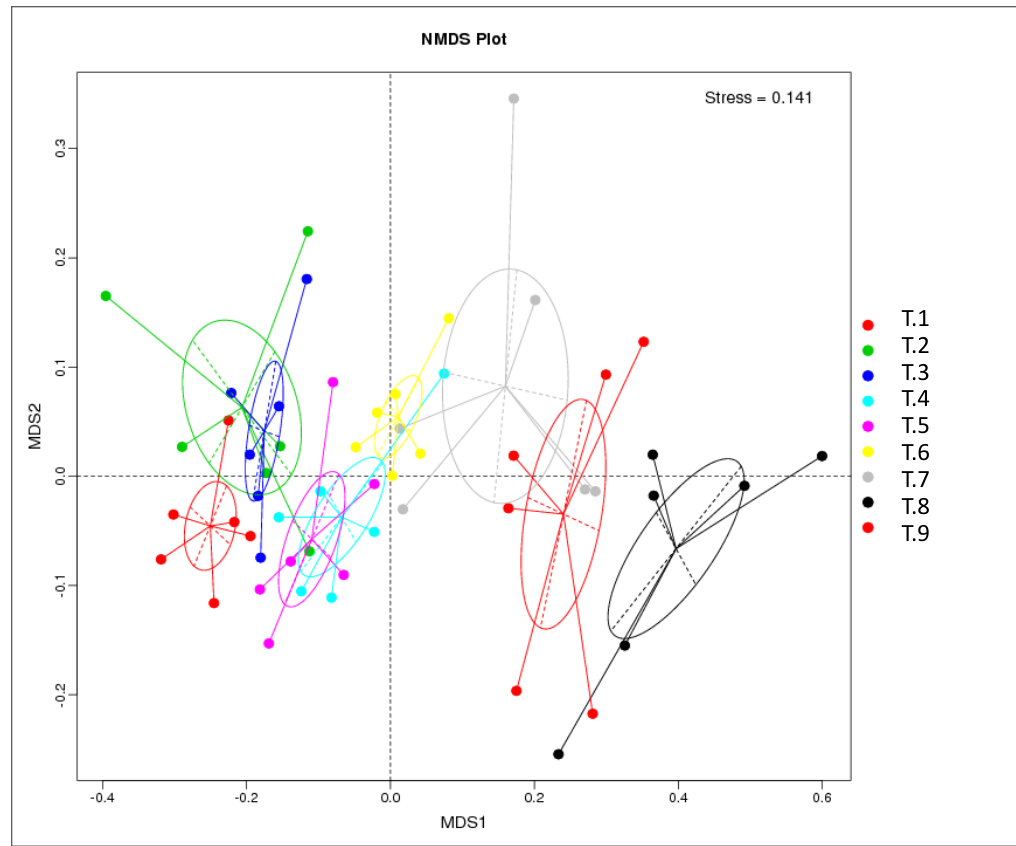
Figure 3. Nonmetric multidimensional scaling analysis to visualize the Bray–Curtis distances of colonic digesta microflora in T1–T9 groups.